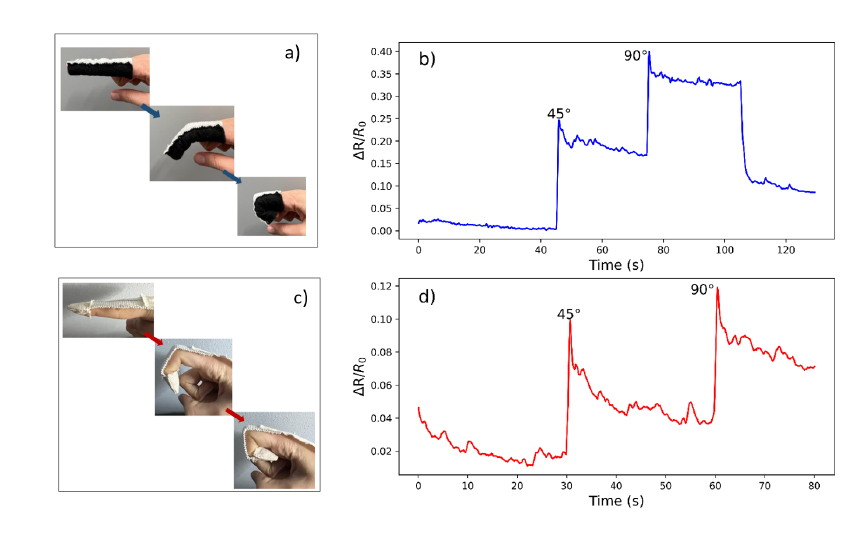
Figure 5. The relative resistance change versus time for Version 1 and Version 2 at various positions: relaxation, 45° and 90°. ( a ) The positions of version 1 sensors at different angles, ( b ) relative resistance changes versus time of version 1 sensor, ( c ) the positions of the Version 2 sensor at different angles, and ( d ) relative resistance changes versus time of the Version 2